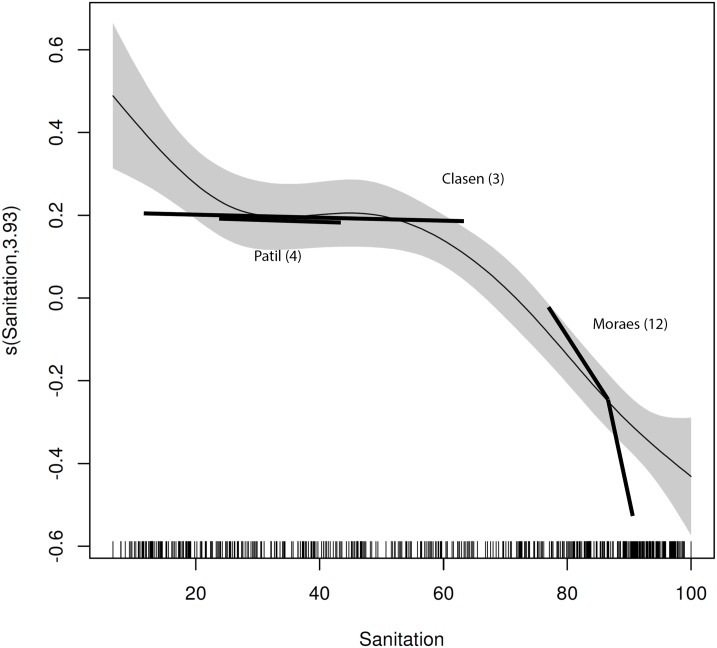
Impact of three sanitation intervention programmes on diarrhoeal morbidity superimposed on GAM model of sanitation coverage on childhood diarrhoeal mortality.